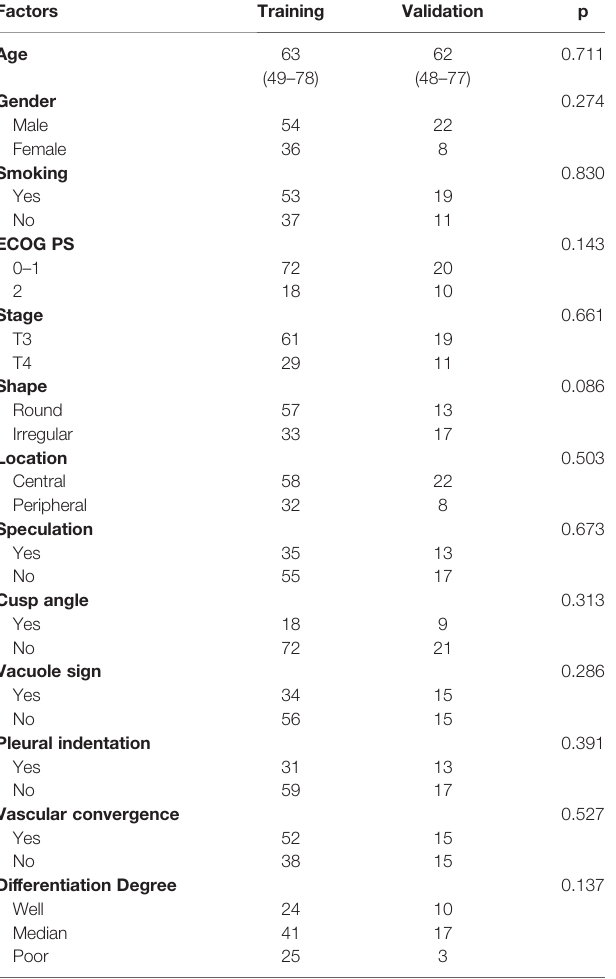
TABLE 1 | The clinicopathological and morphological factors of patients with NSCLC in the training dataset and validation dataset. Factors